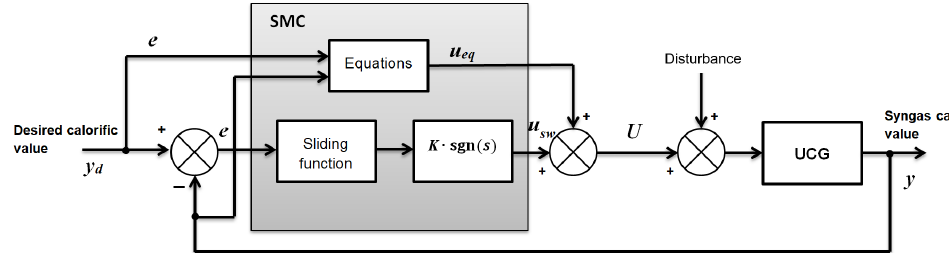
Figure 22. Block diagram of sliding mode control (SMC).